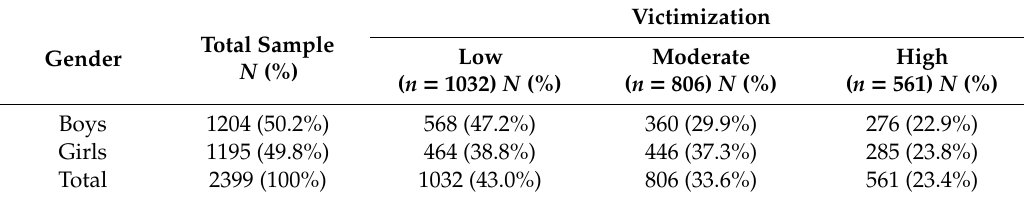
Table 1. Distribution of adolescents according to cybervictimization and gender clusters.